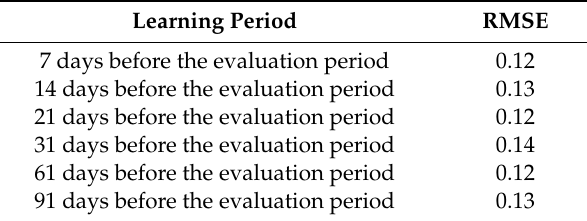
Table 12. RMSE when the learning period is